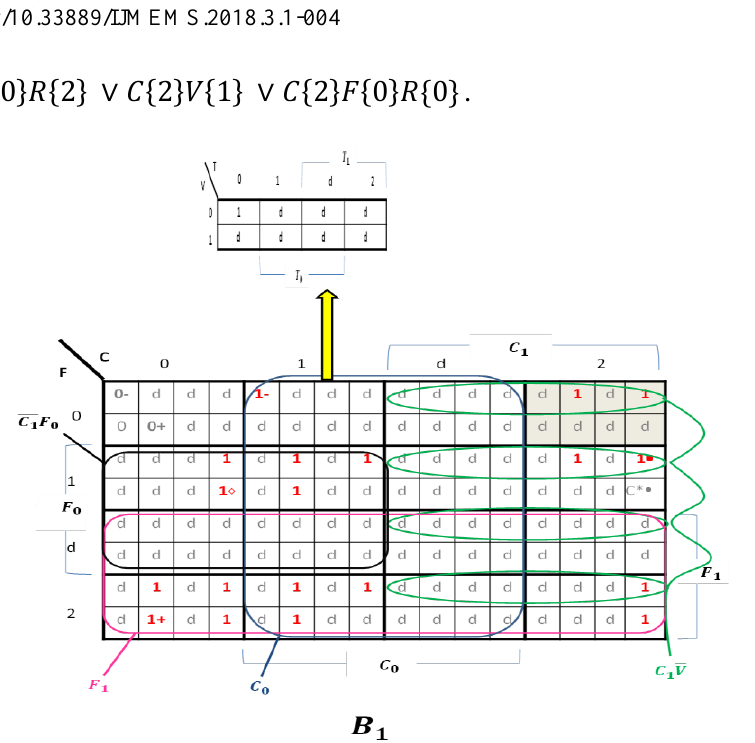
Fig. 2. A representation of 𝑩 (introduction of party bans) by a 7-variable CKM, a translation of Table 3 in 𝑰 Hartmann and Kemmerzell (2010), with prime implicant loops covering the asserted part 𝑩 we assume C* = 0, and hence we obtain a lower bound 𝑩